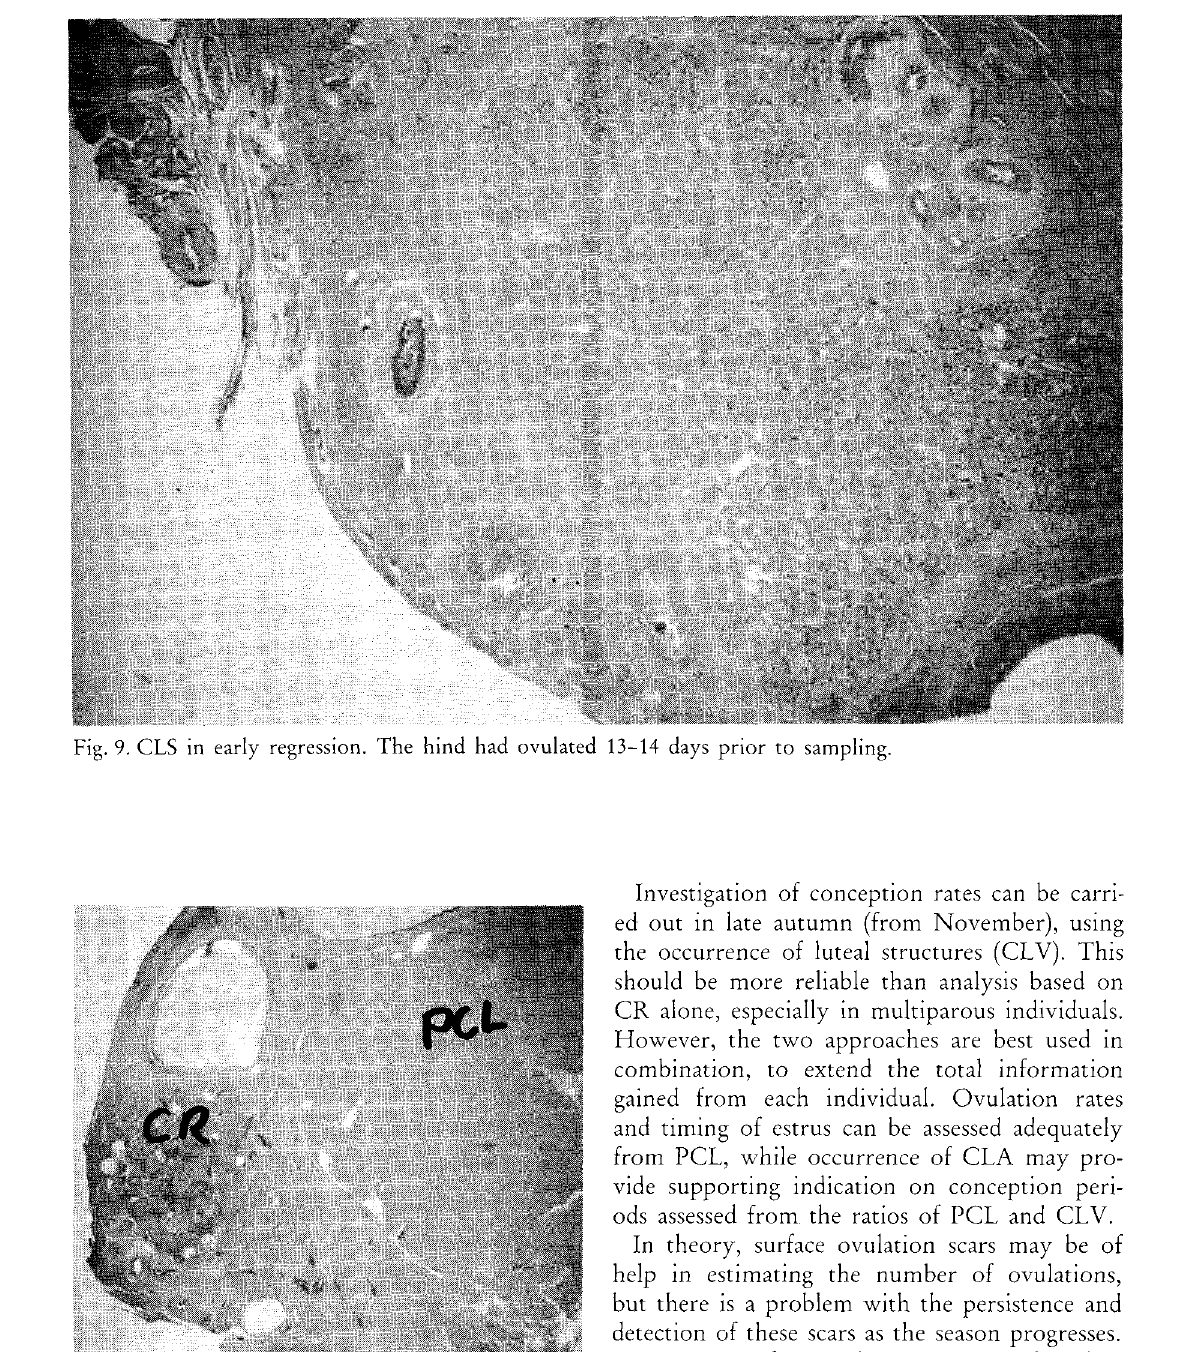
Fig. 9. CLS in early regression. The hind had ovulated 13-14 days prior to sampling.